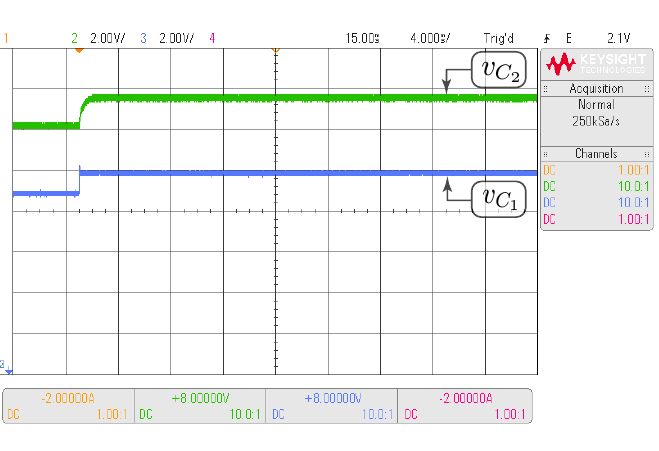
(2 V/div), CH3: v C (2 V/div), and time 2 1